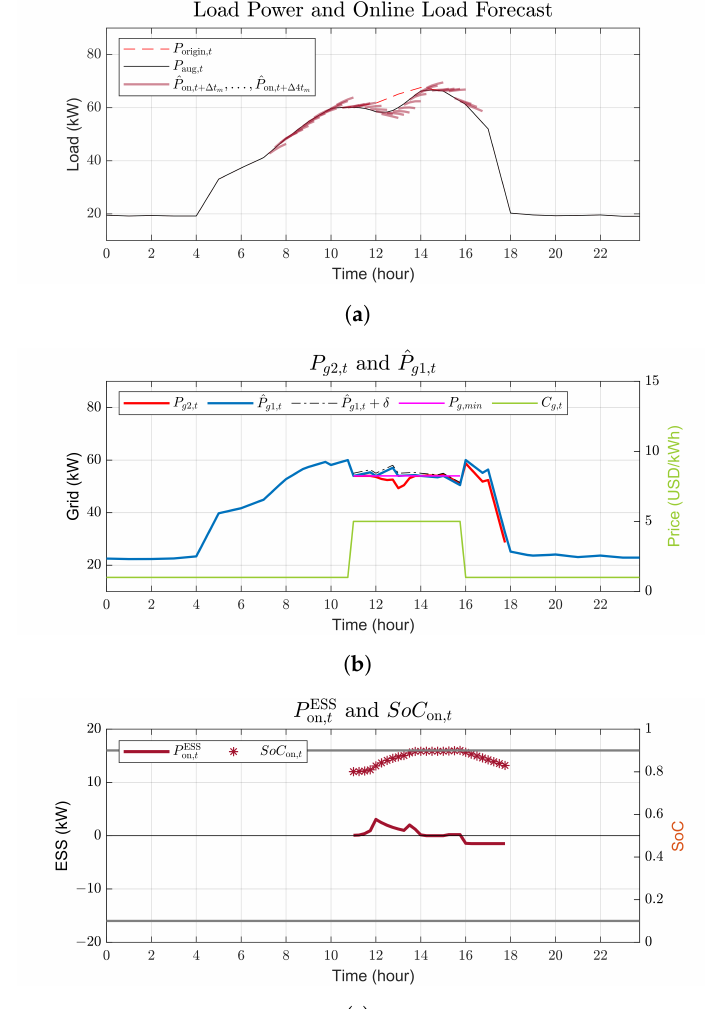
Figure 17. Online ESS operations with initial SoC on, t value being 0.8. ( a ) Online load forecast, ( b ) The estimated power ˆ P g 1, t and real power P g 2, t from the main grid by using both ESS off and ESS on , ( c ) The amount of charging or discharging of ESS on and SoC on, t